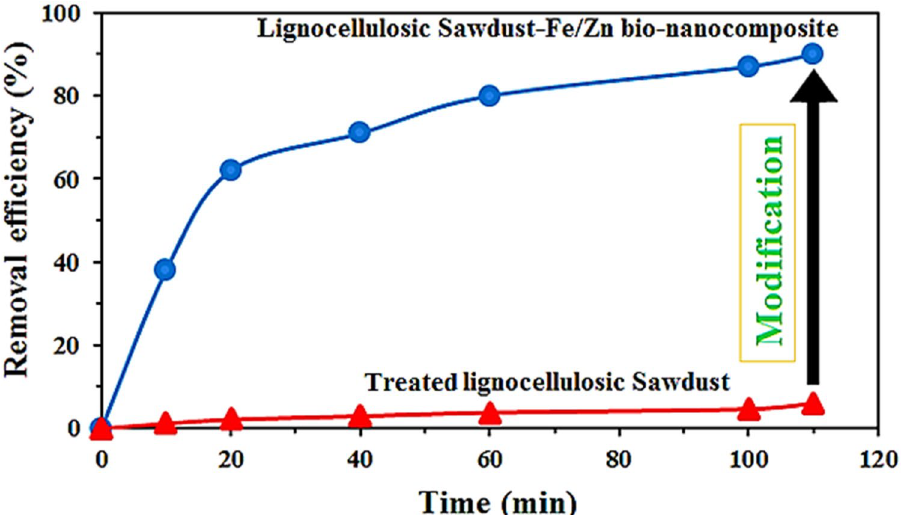
Figure 8. Comparison of Treated lignocellulosic sawdust and Lignocellulosic sawdust-Zn/Fe bio- nanocomposite for the removal of RO16 (initial pH 4, 20 mg Treated lignocellulosic Sawdust 100 mL solution, initial RO16 concentration 10 mg L −1 , and agitation speed 50